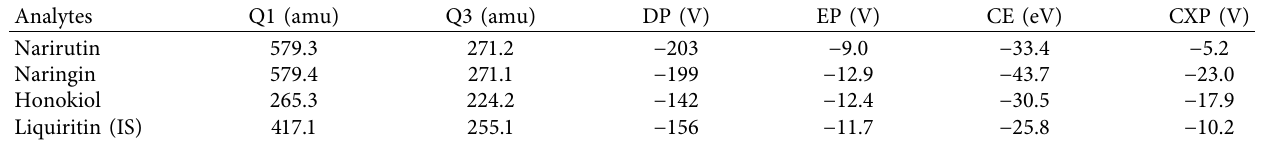
Table 1: The optimized MRM parameters of narirutin, naringin, honokiol, and liquiritin (IS).